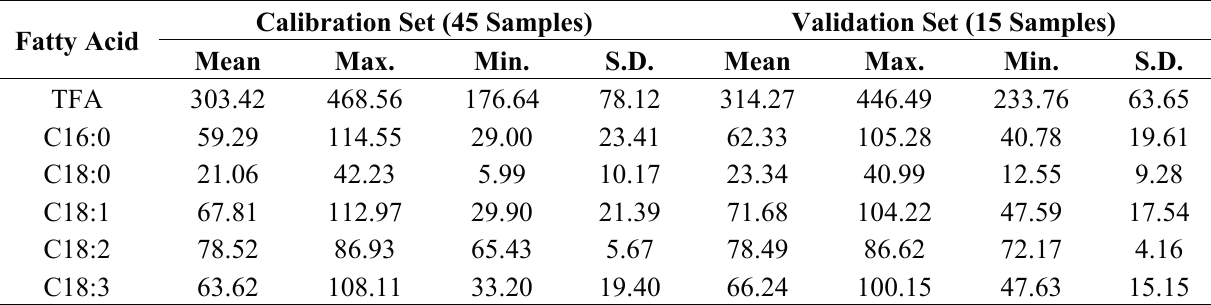
Table 1. Descriptive statistics of the sample sets of C. vulgaris used for calibration and validation (Fatty acids expressed as mg/g dry cell